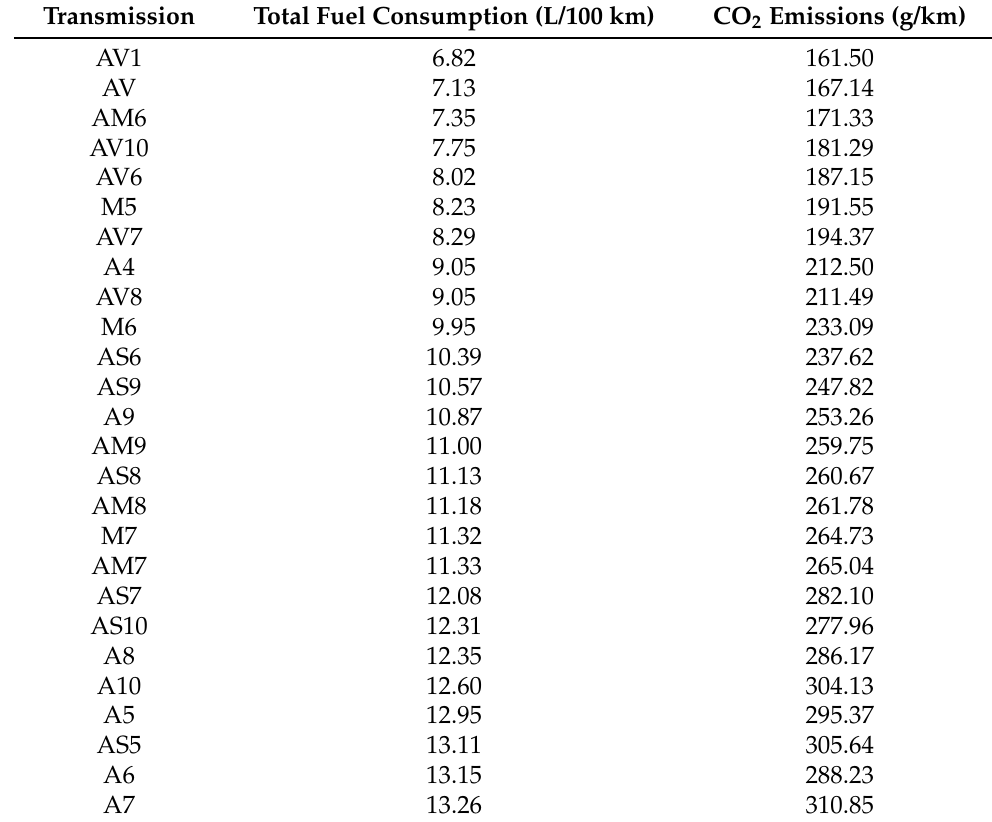
Table 7. CO 2 emissions (g/km) and total fuel consumption (L/100 km) of each transmission type.